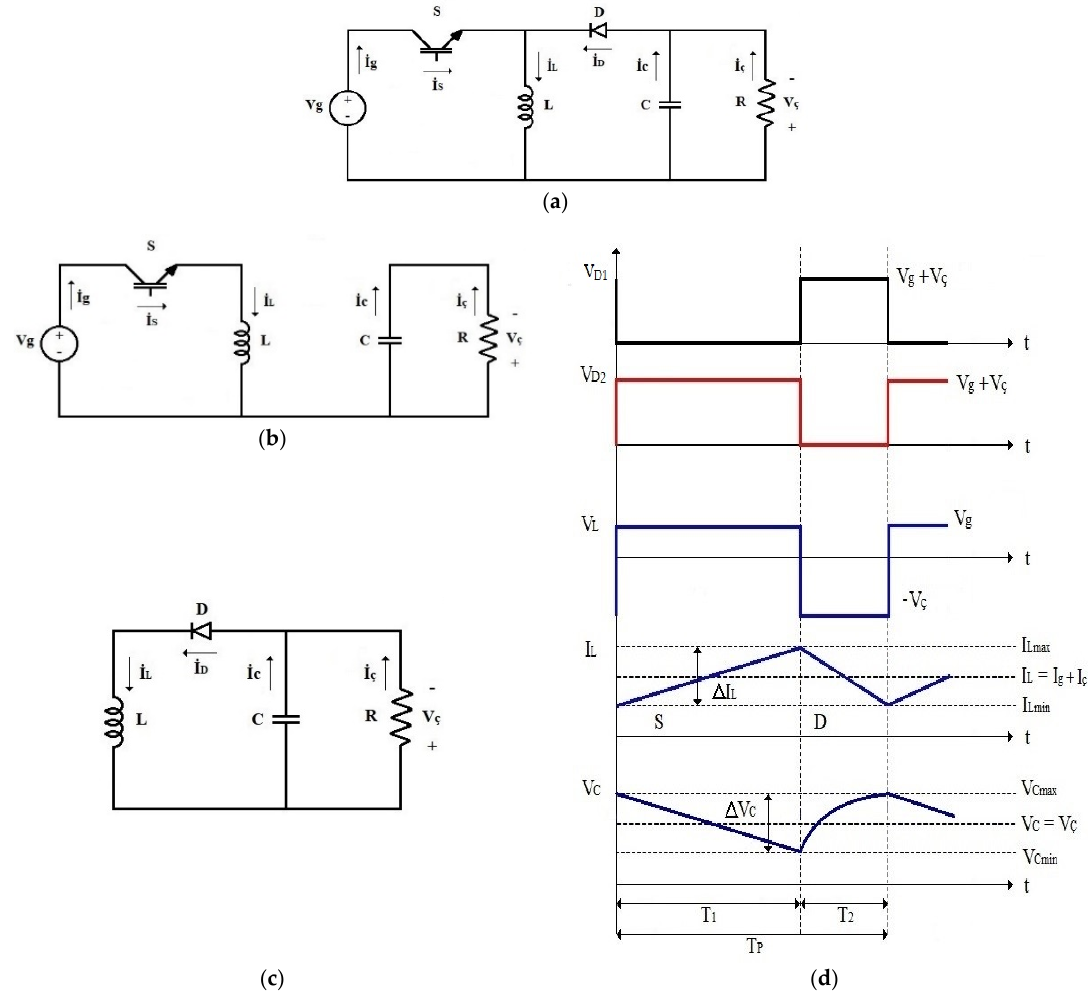
Figure 17. ( a ) Basic circuit, ( b ) status with turned-on IGBT, ( c ) status with turned-off IGBT, and ( d ) waveforms of the circuit of the buck–boost convertor.